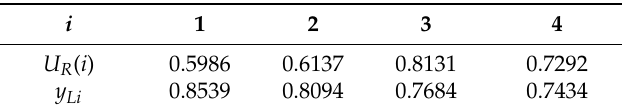
Table 9. The y Ri and y Li